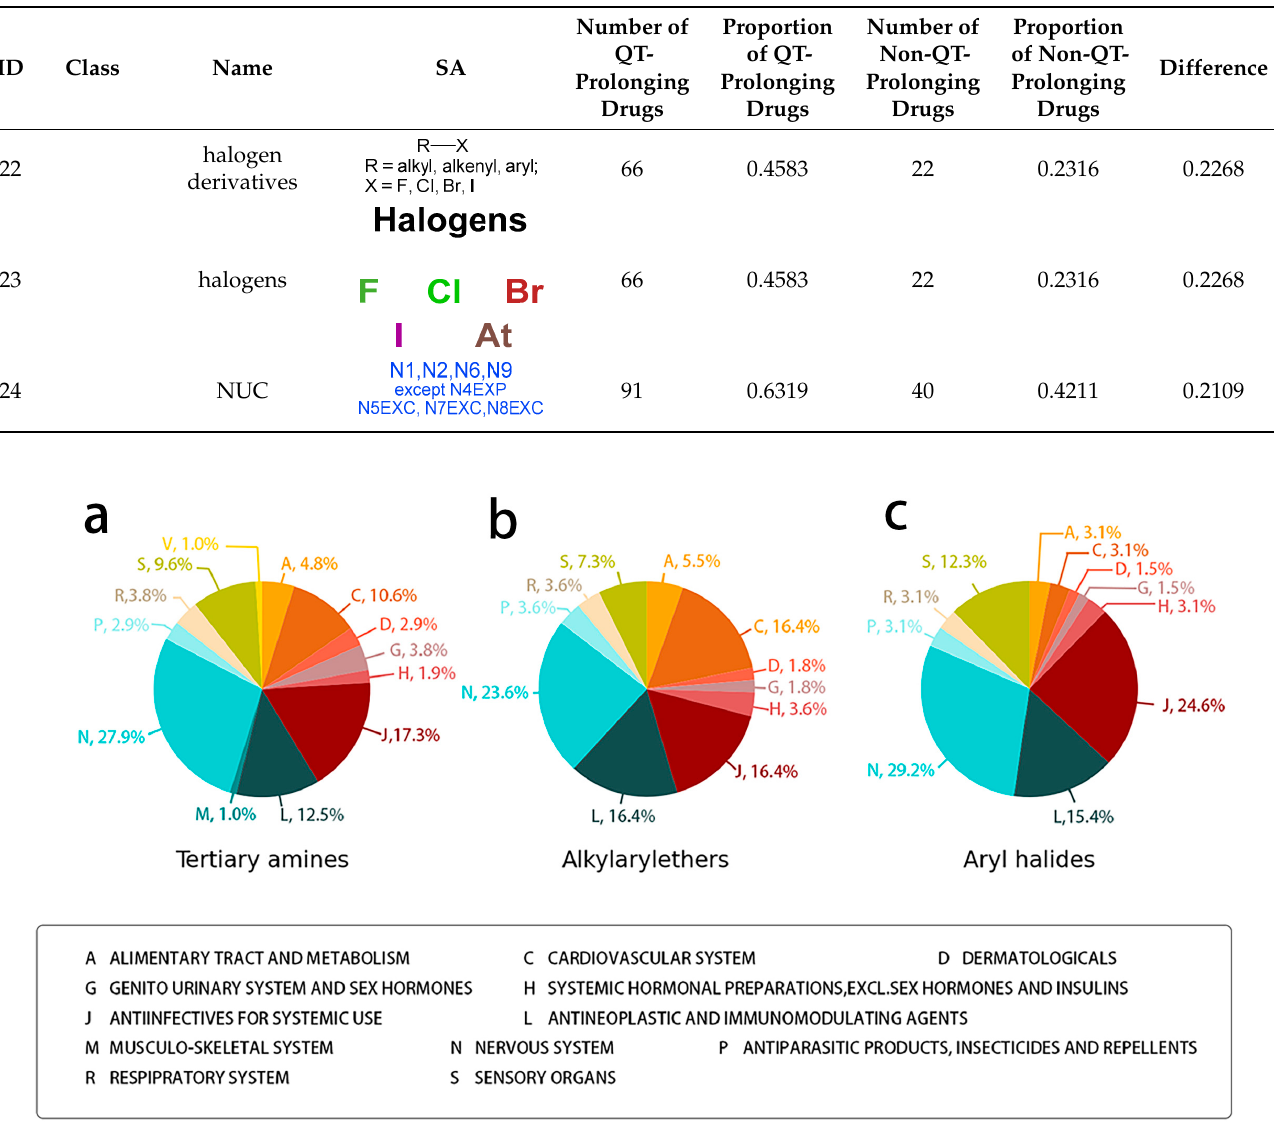
Figure 1. ( a ) Distribution of drugs containing tertiary amines among different therapeutic categories of QT-prolonging drugs; ( b ) distribution of drugs containing alkylarylethers among different therapeutic categories of QT-prolonging drugs; ( c ) distribution of drugs containing aryl halides among different therapeutic categories of QT-prolonging drugs.